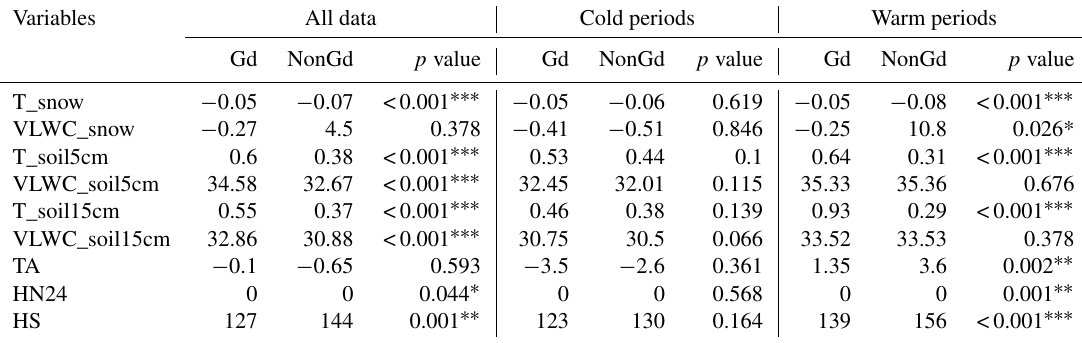
Table 3. Sant’Anna: summary statistics showing median values of various variables for gliding days (Gd) and non-gliding days (NonGd). For each variable, distributions were contrasted (Mann–Whitney U test), and the level of significance p is given. Temperatures are in degrees Celsius, VLWC is in percent and snow height is in